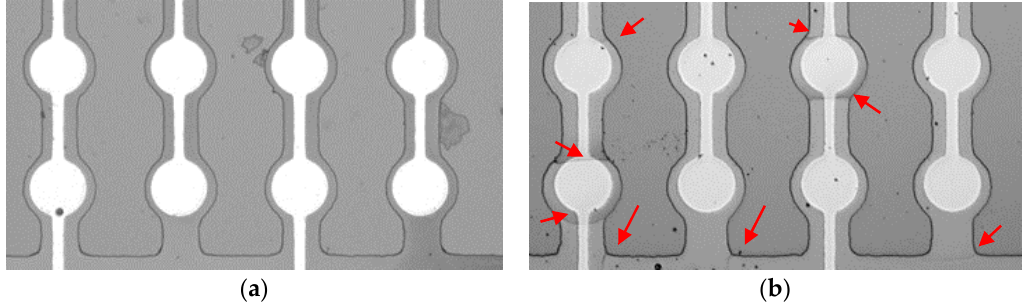
Figure 10. Mechanical behaviors of pMUTs with partial-etching using ( a ) fibered epitaxial and ( b ) monocrystalline films.